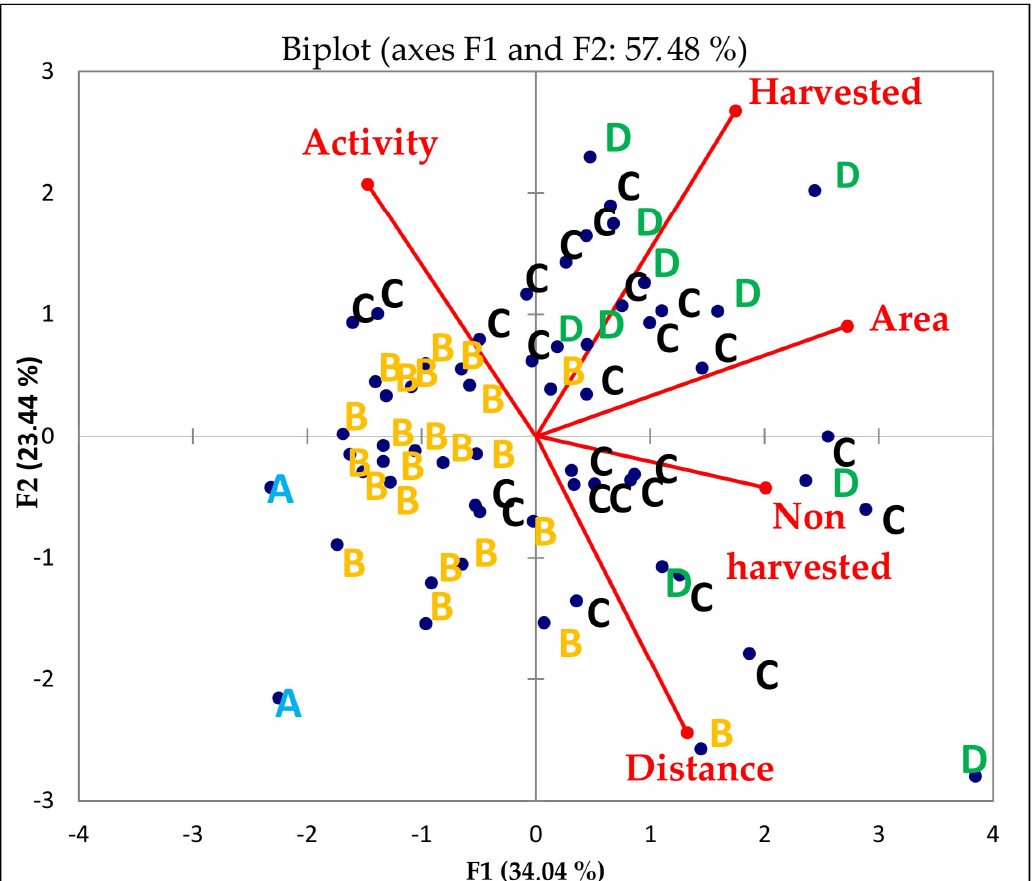
Figure 5. Correlation between several variables and the number of species cultivated in each plot. ( A ) 1–4 species cultivated, ( B ) 5–8 species cultivated, ( C ) 9–12 species cultivated, and ( D ) 13–16 species